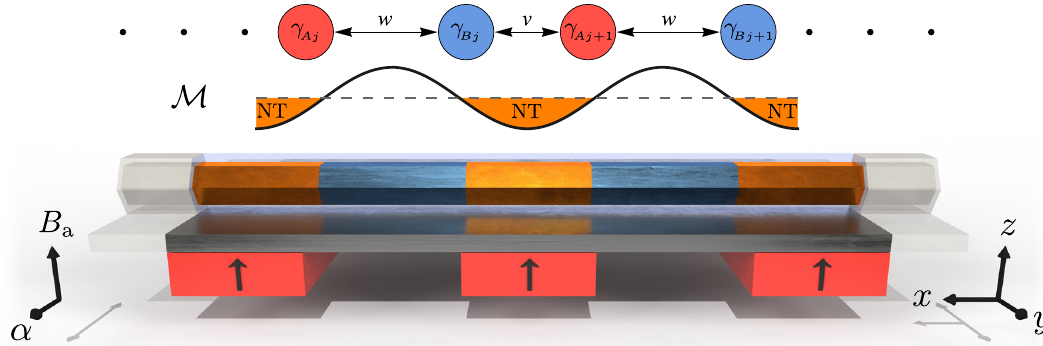
Fig. 1 Lattice of 0D Majorana modes in a proximitized nanowire. A semiconducting nanowire with Rashba spin-orbit coupling α covered by a superconducting shell, with a periodically-modulated magnetic fi eld induced by a regular array of nanomagnets and an externally applied fi eld B a . The periodic modulation of the fi eld induces topologically nontrivial (NT) segments alternating to trivial ones, which correspond respectively to negative and positive values of the local Majorana mass M . 0-dimensional quasi-Majorana modes γ Aj and γ Bj localize at the boundaries between trivial and nontrivial segments, with overlaps w and